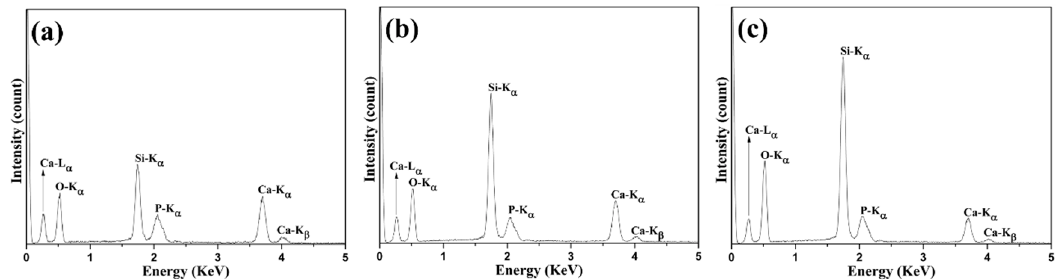
Figure 4. Energy dispersive spectroscopy (EDS) spectra of spray dried ( a ) 58S, ( b ) 68S, and ( c ) 76S BG powders.